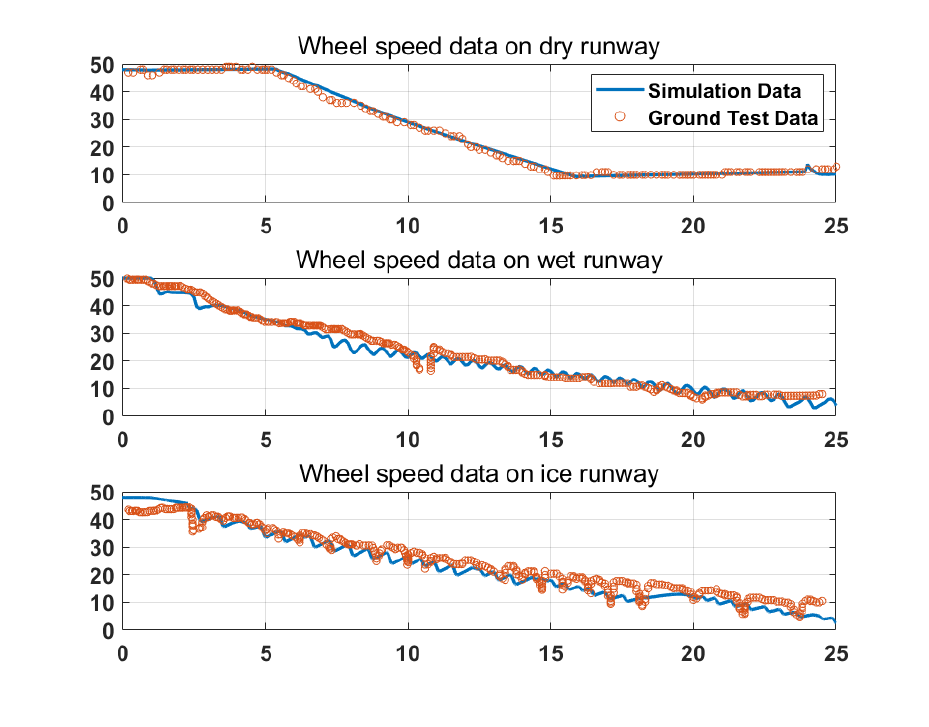
Figure 14. Comparison of ground test wheel speed data and simulation wheel speed data.